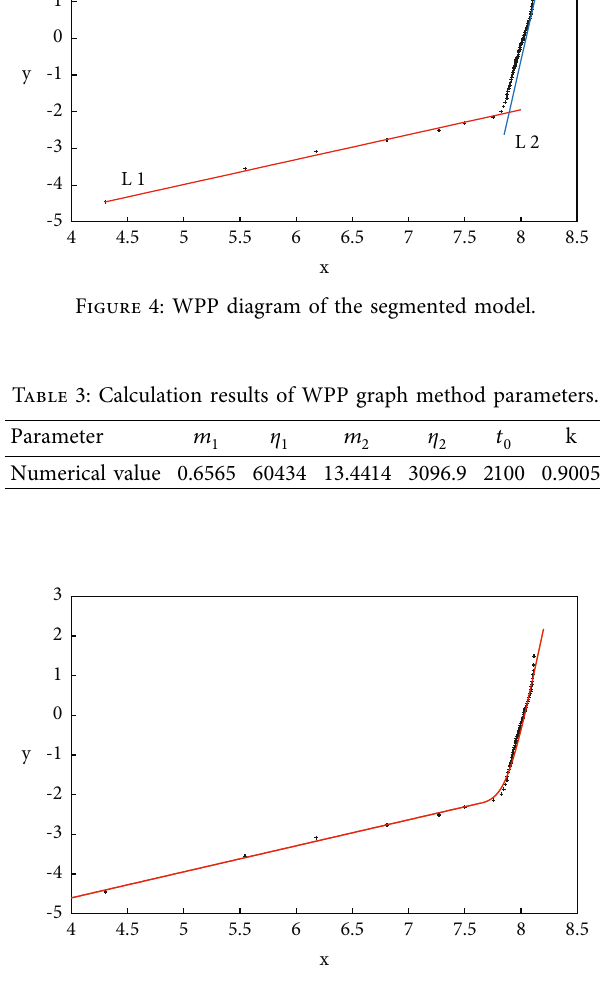
Figure 5: WPP fitting curve diagram of the segmented model.